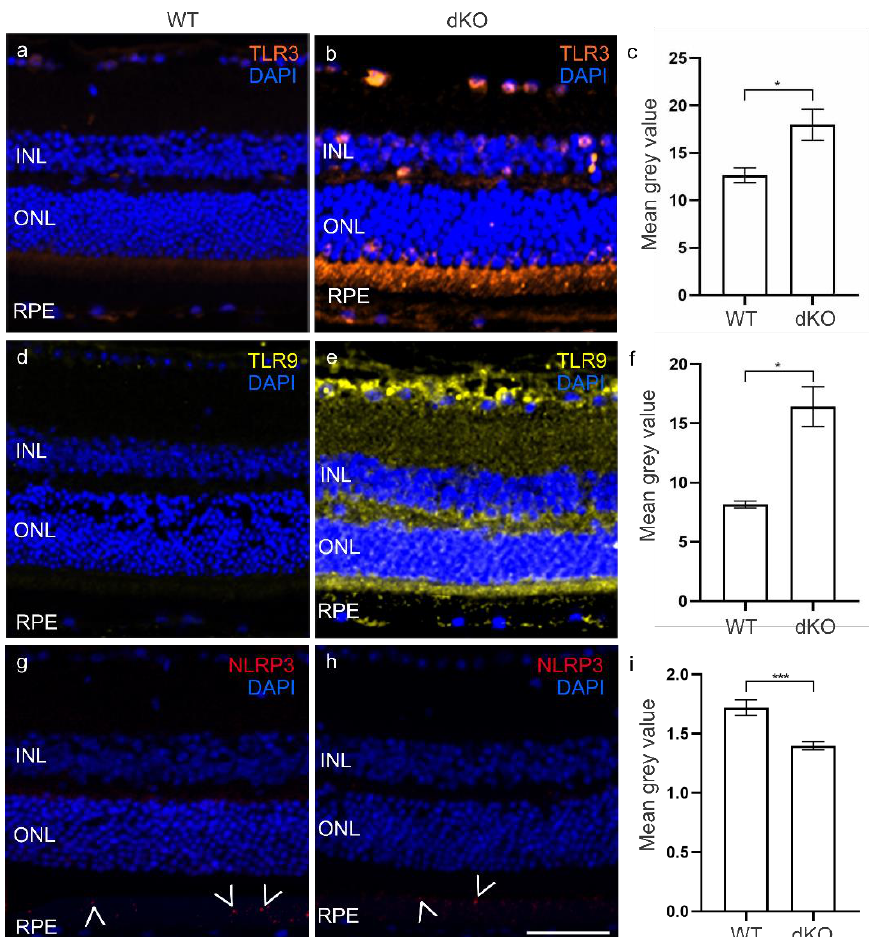
Figure 2. Confocal microscopy analysis of the TLRs and NLRs. One-year-old WT and dKO mice retina focusing on the vicinity of the optic nerve ( a – h ). In dKO retina, TLR3 ( b ) and TLR9 ( e ) showed significant increases by ~42%, * p = 0.04 ( c ), and ~100%, * p = 0.03 ( f ) compared to WT retinas ( a , d ), respectively. The dKO retina ( h ) displayed ~19%, *** p = 0.0005 ( i ), a significant decrease in NLRP3 levels as compared to WT retina ( g ). Scale = 20 µm.